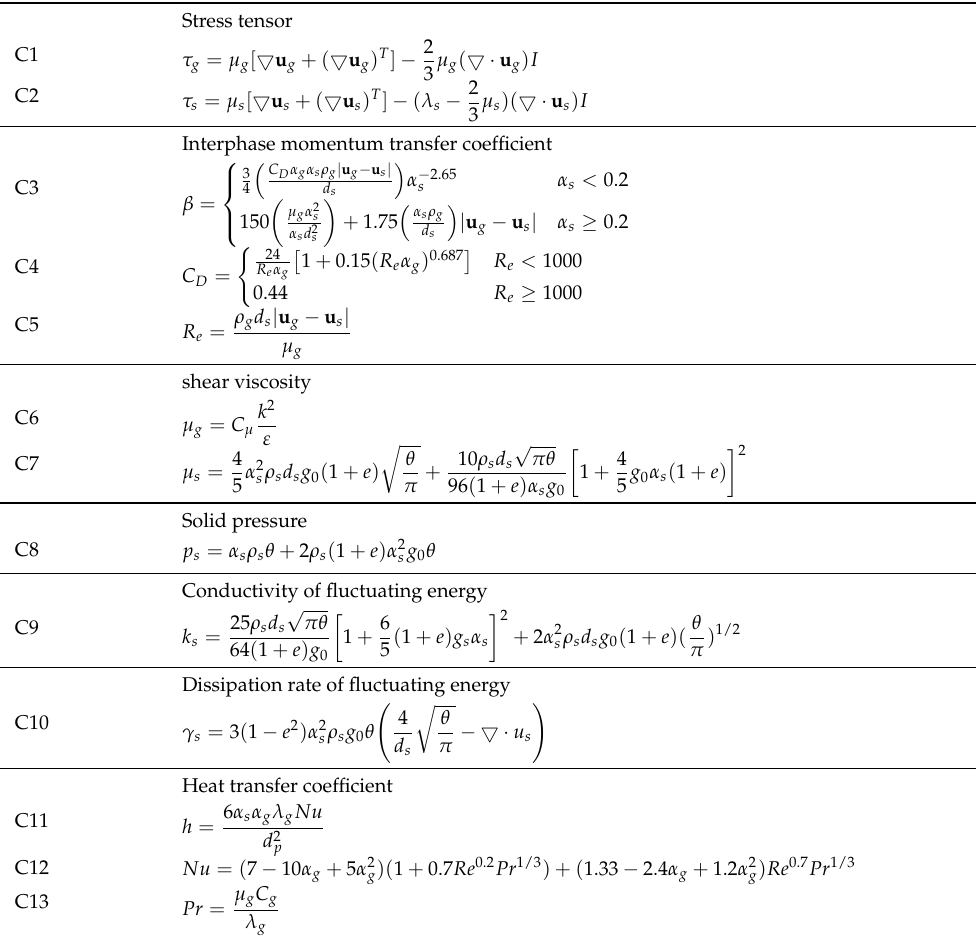
Table A2. Conservation